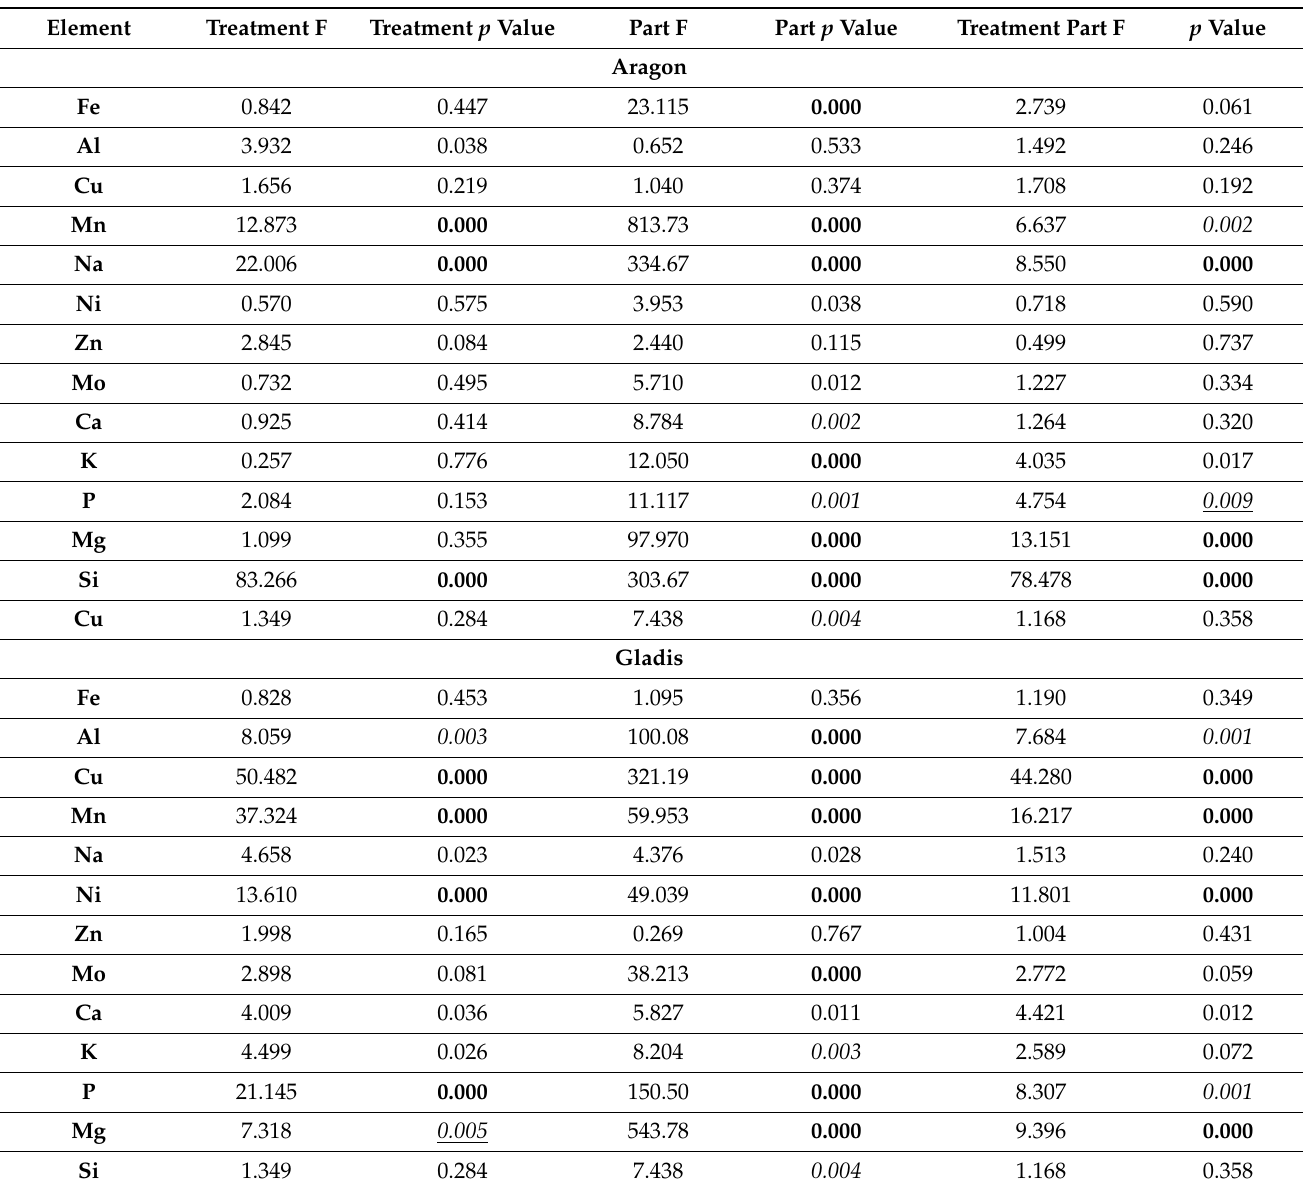
Table 1. Two-way ANOVA for the chemistry analyses of the different parts of the plants (root, leaf, fruit) treated with different concentrations of Silicon (Non-treated, Si-Low, Si-High). In the different columns the F statistics are reported, and the p values of the ANOVA according to plant treatments, plant parts, and their interaction for all the elements analyzed in the study. In bold p < 0.001; in italics p < 0.005; in italics underscored p <